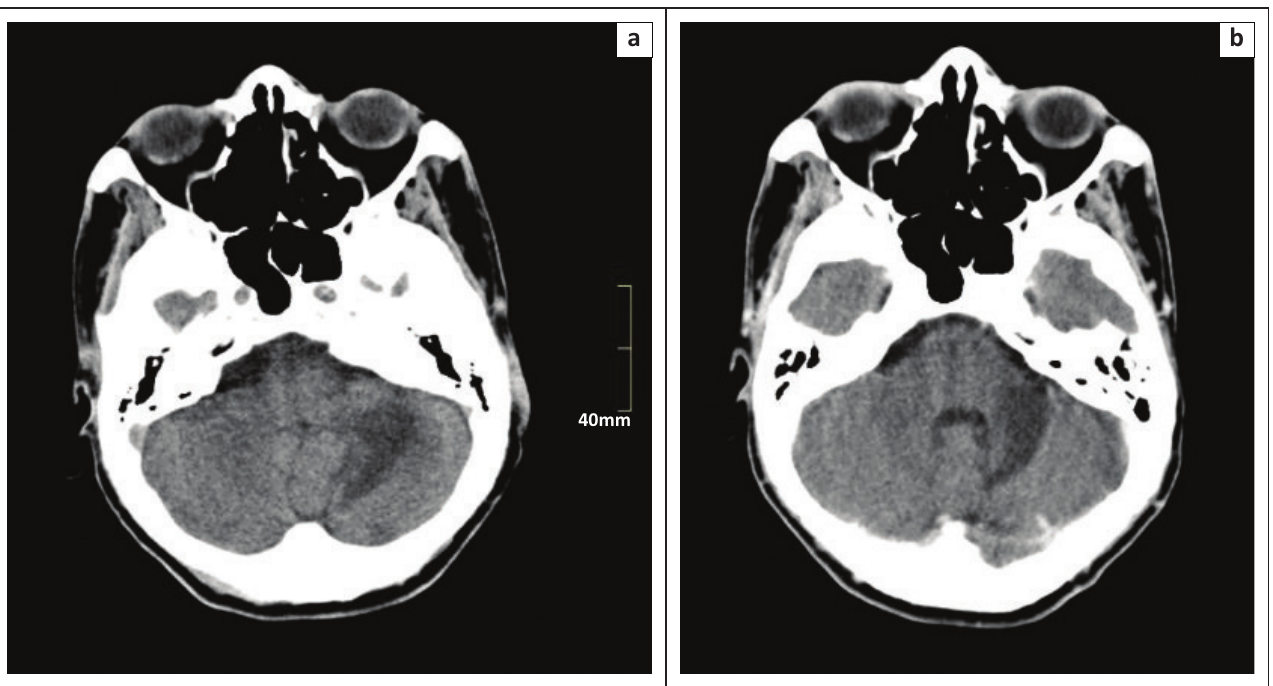
FIGURE 5: Axial (a) pre- and (b) post-contrast CT scan of the patient discussed in Case 5, demonstrating low density in the left cerebellar hemisphere with no contrast enhancement of the